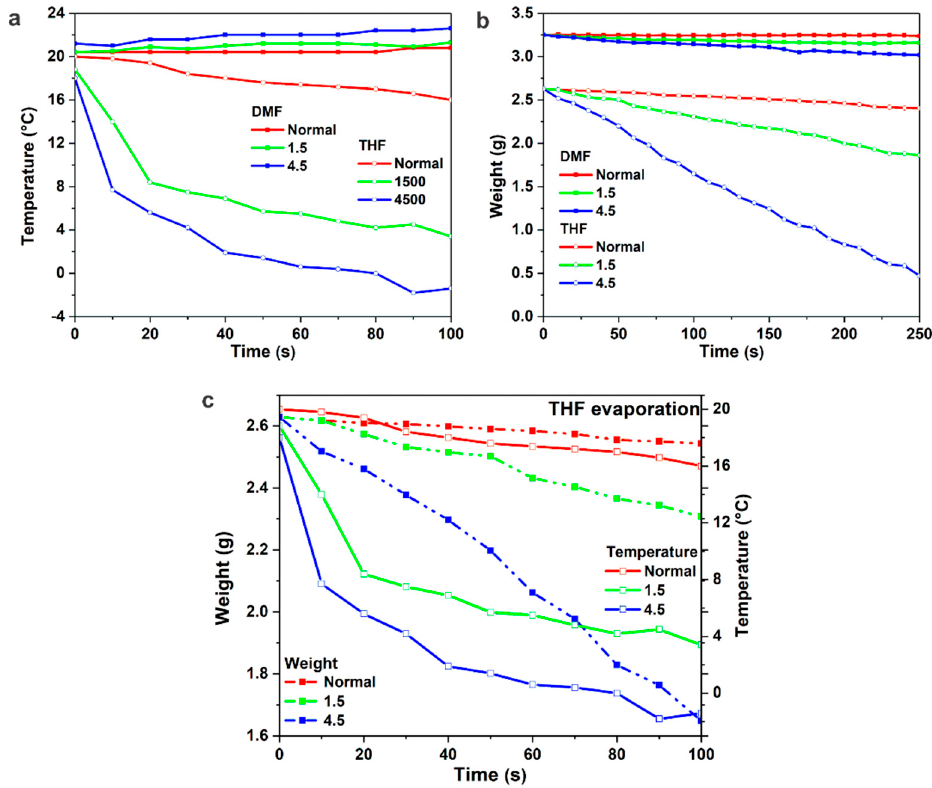
Figure 5. Influence of evaporation conditions (normal evaporation, Q g : 1.5 and 4.5 L/min) on evaporation (weight, g) ( a ) and temperature ( ° C) of the top surface ( b ) for solvents DMF and THF. ( c ) Influence of evaporation conditions on the evaporation (weight loss) and temperature drop for THF.